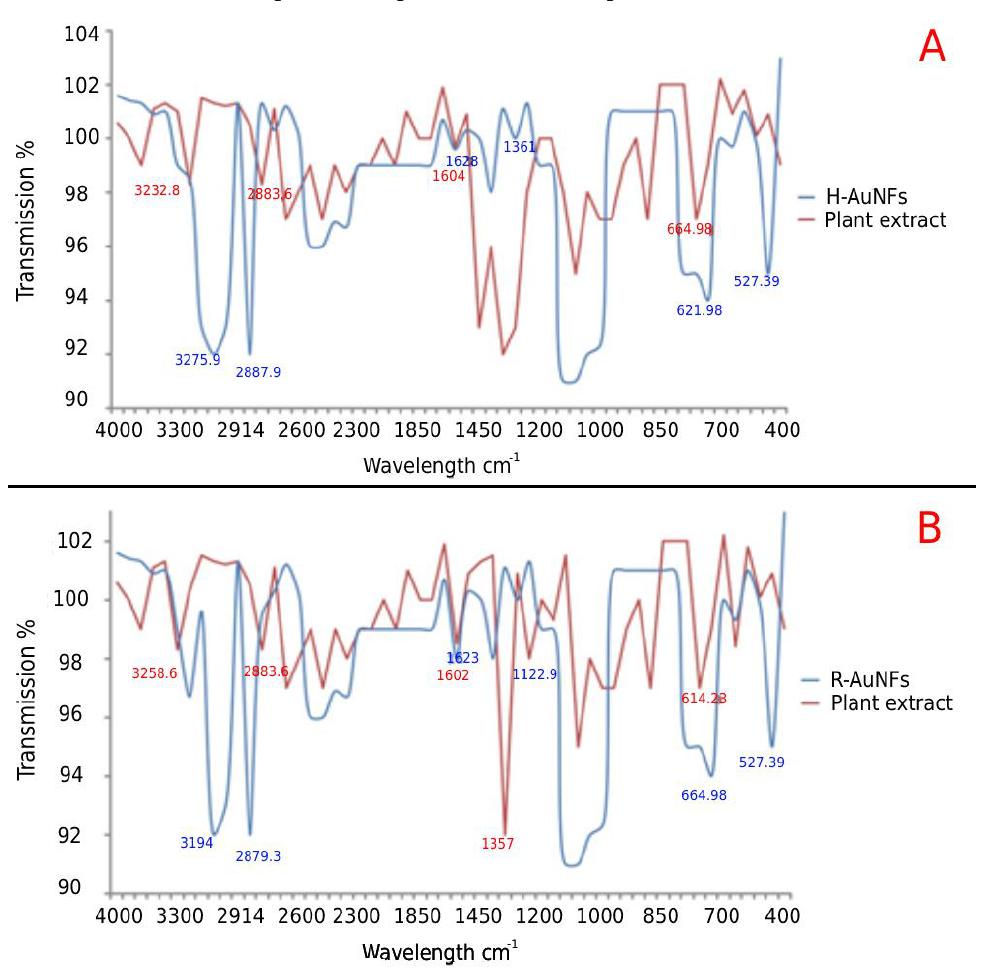
Figure 6. FTIR analysis of AuNFs and plant extracts. AuNFs represent gold nanoflowers; H-AuNFs from Helichrysum italicum extract ( A ); and R-AuNFs from Rosmarinus officinalis extract ( B ).